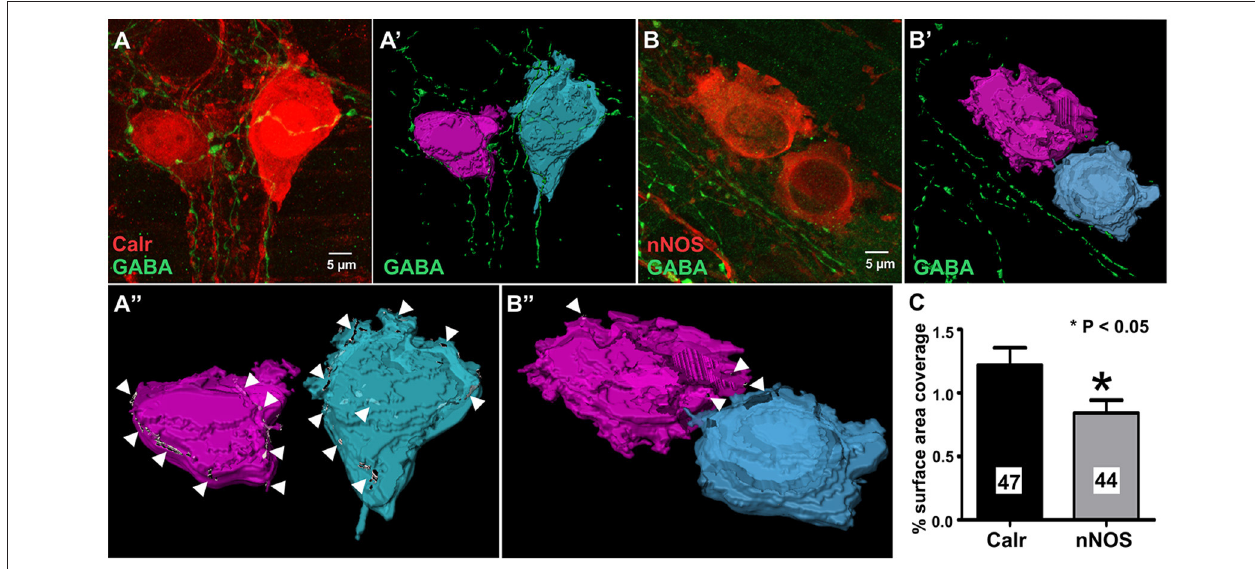
FIGURE 4 | GABA terminals cover a larger proportion of the total cell surface area of 3D rendered calretinin- compared to nNOS- neurons. Example confocal micrographs of myenteric plexus stained for Calretinin and GABA (A) , and nNOS and GABA (B) . 3-D rendered surfaces of the calretinin- (A’) , nNOS- (B’) immunoreactive cell bodies, GABA-immunoreactive varicosities and terminals (A’,B’) . (A”,B”) Cell surface area receiving GABA terminals (arrow heads) detected by surface-surface contact analysis. (C) The mean percentage of total cell surface area covered by GABA terminals for Calretinin- or nNOS-immunoreactive neurons. Calretinin neurons have a significantly larger percentage surface cell body area that are covered by GABA terminals. All data were analyzed using the 3D image analysis software Imaris x64 (Bitplane, version 9.0.0).